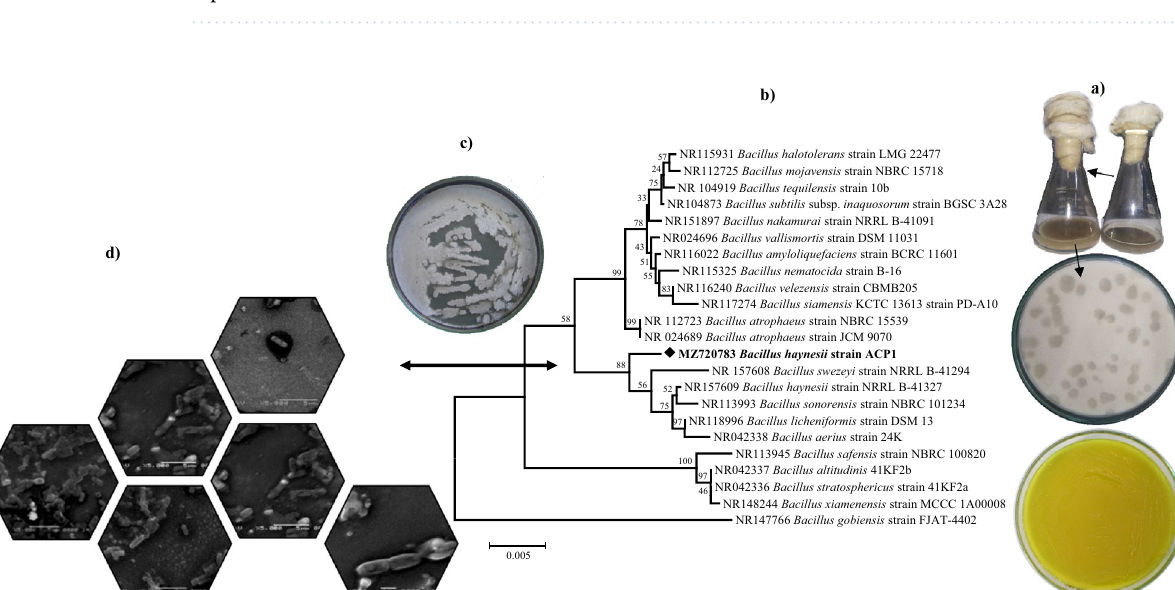
Figure 2. Isolation, screening, and identification of phosphate solubilizing bacteria (PSB) and acid phosphatase-producing bacteria, (a) isolation and qualitative screening of PSB and ACP-producing bacteria, (b) phylogenetic tree based on 16S rRNA gene sequence analysis showing the relationship of B. haynesii strain ACP1 with reference strains (NCBI GenBank) constructed using the neighbor-joining method with the aid of MEGA 7.0 program, (c) cultural feature of B. haynesii strain ACP1 agar plate, and (d) SEM micrograph of B. haynesii strain ACP1 showing cell morphology at a magnification of ×5000 and 10,000 with 15